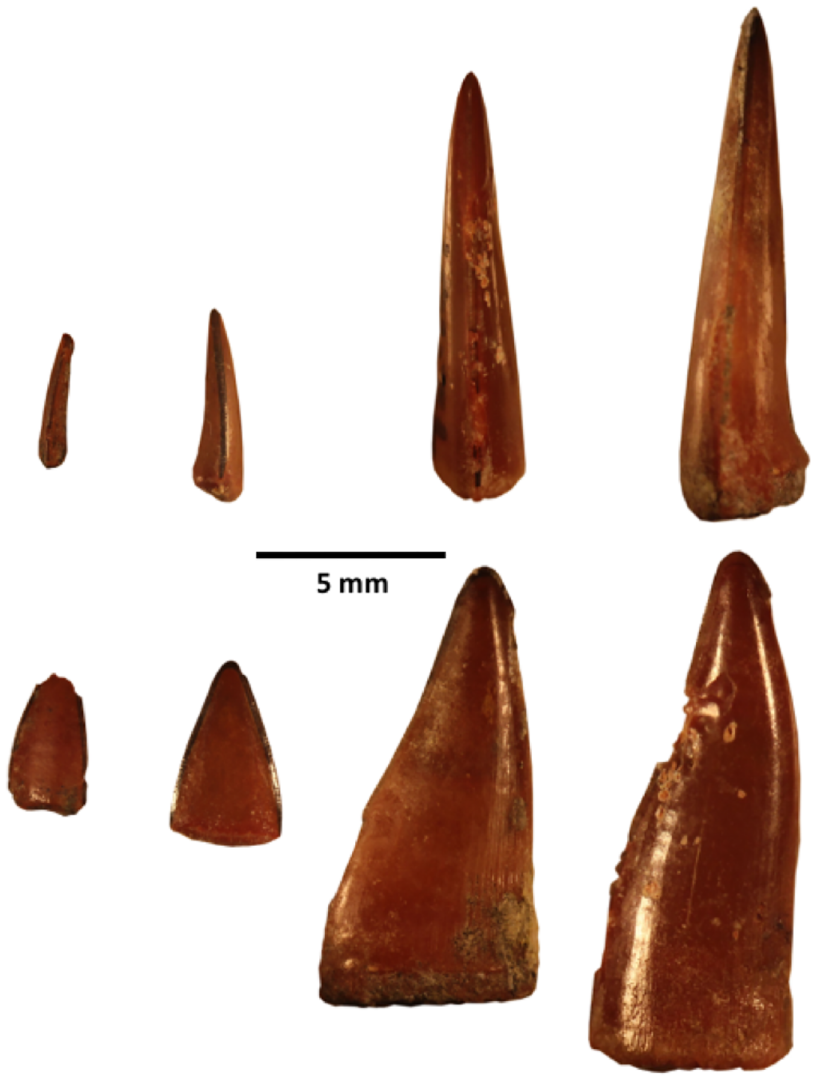
Fig 3. Fossil Sphyraena sp. teeth from Nosy Makamby. Upper row in side view, lower row shows same teeth rotated into labial/lingual view. Left to right, UA 10435, 10437,10436, 11188.